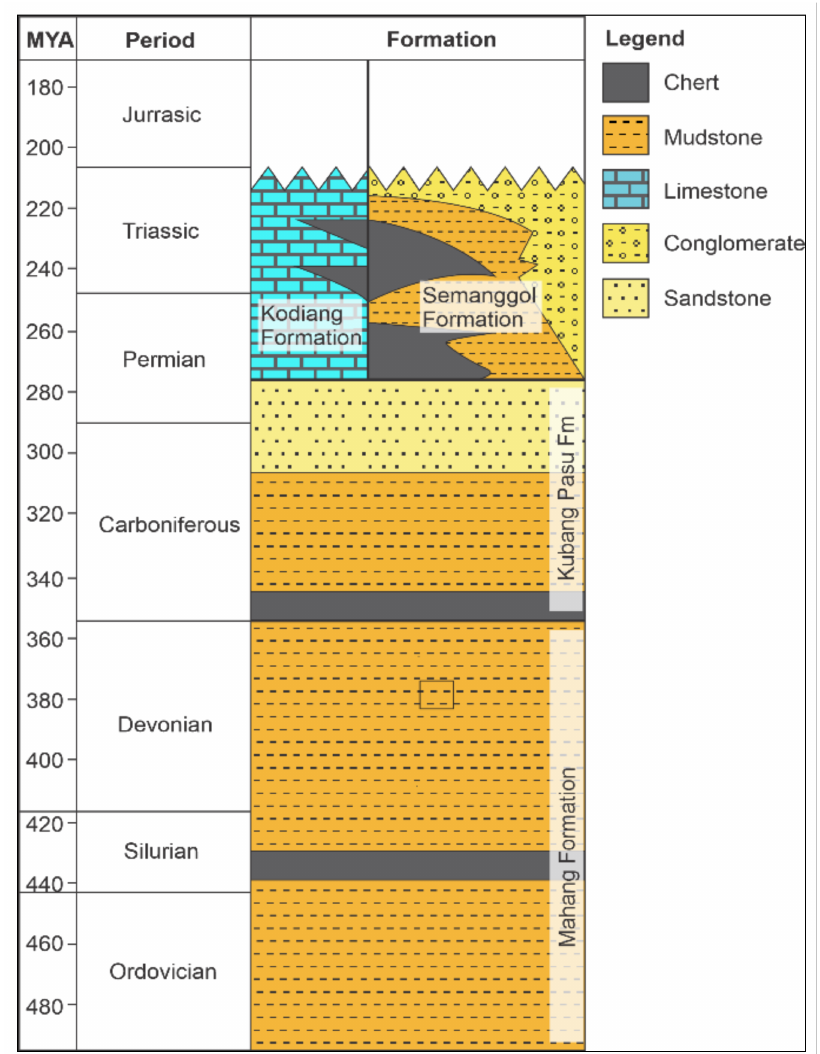
Figure 3. Stratigraphy chart of the Muda River basin. Modified after